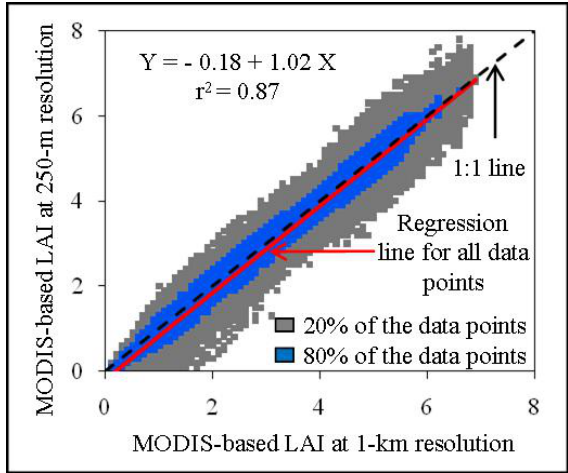
Figure 6. Study-area-wide comparison of LAI from the original 1-km and enhanced